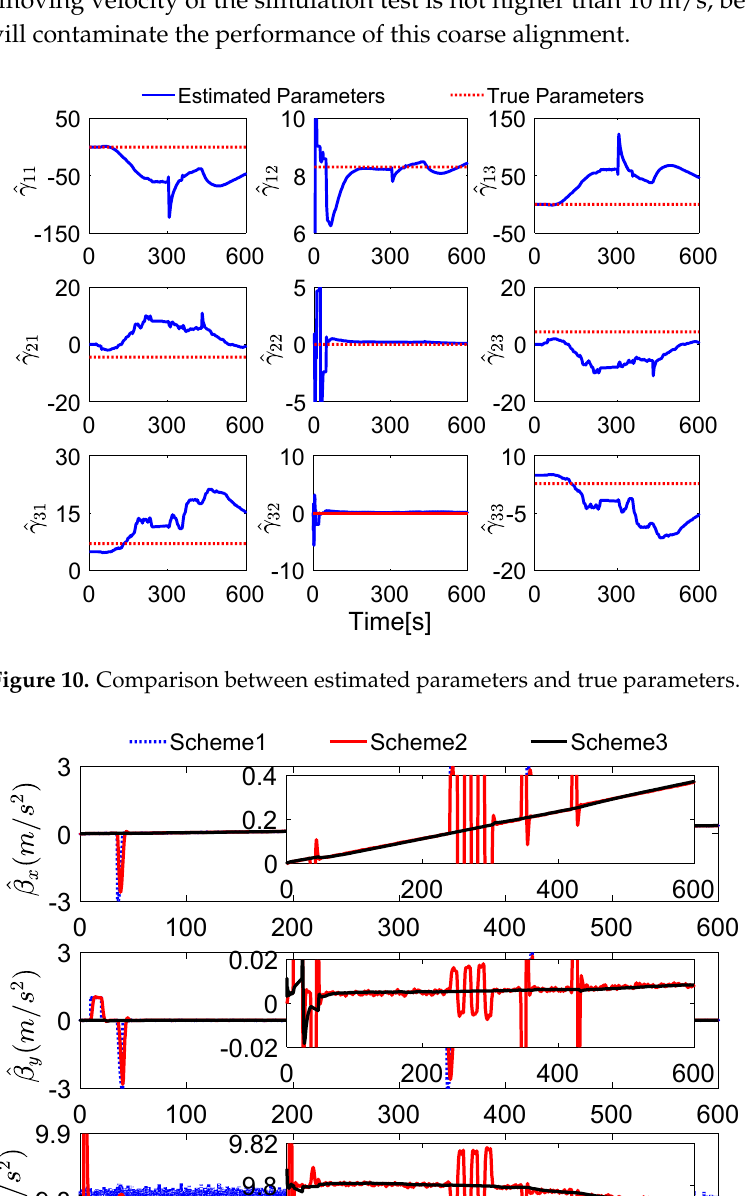
14 of 24 Figure 9. Curves of vehicle motion.